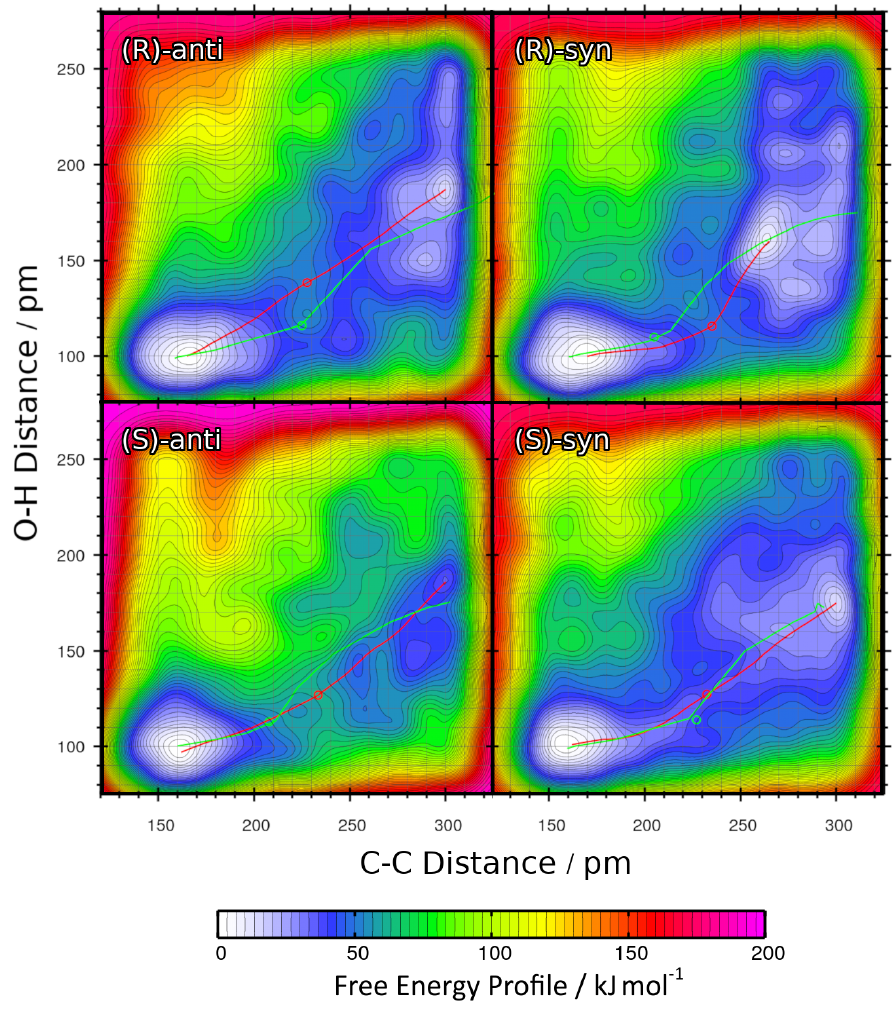
Figure 10. Free energy profiles of the aldol reactions (R=iPr) in DMF computed from HyAIMD metadynamics; definition of collective variables see Figure 2b. Red curves depict the minimum energy paths from educts (upper-right energy basin) to products (lower-left energy basin). Green curves show the results of static NEB calculations for comparison. Green circles denote the statically determined transition state.